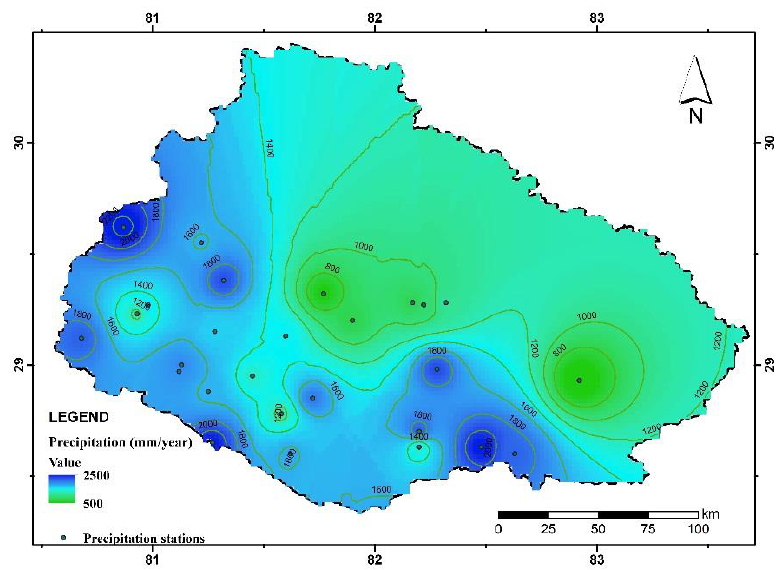
Figure 4. Spatial distribution of average annual precipitation (mm) in KRB for the period of 1981– 2012.